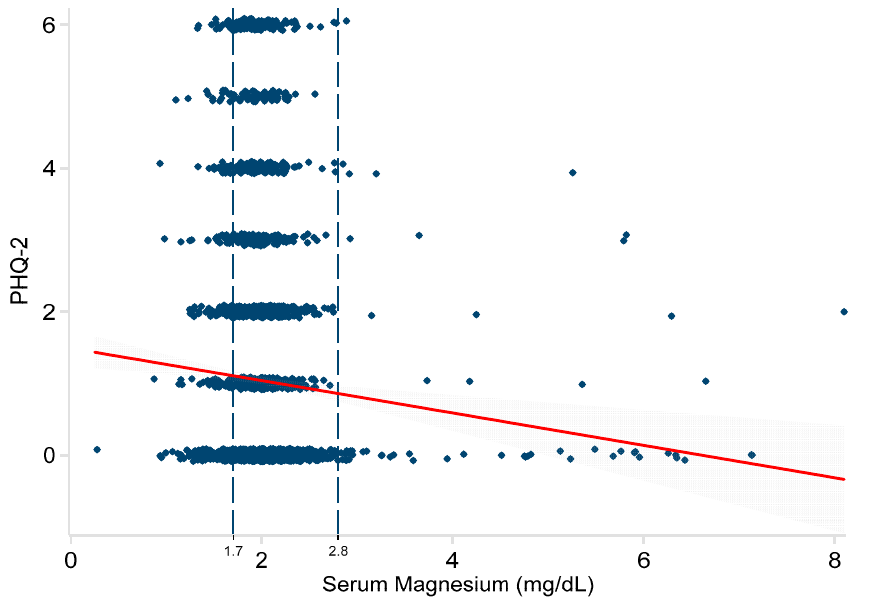
Figure 2. Relationship of serum magnesium to PHQ-2 scores in 3596 adults. Patient Health Questionnaire-2 (PHQ-2). The red line represents the least-squares regression estimate. The grey area demonstrates the 95% confidence interval around that estimate. The vertical dashed lines represent the normal range of serum magnesium. Table 2. Multivariate regression analyses.